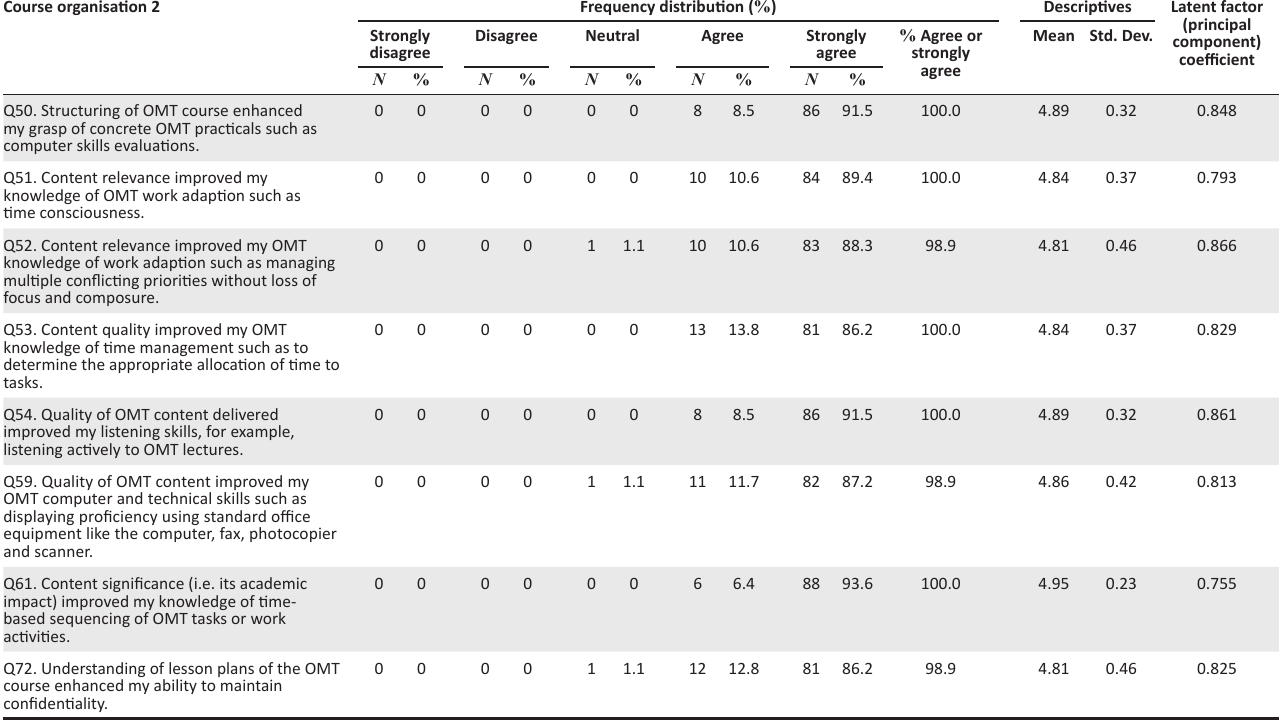
TABLE 9: Effects of course organisation 2. Course organisation 2